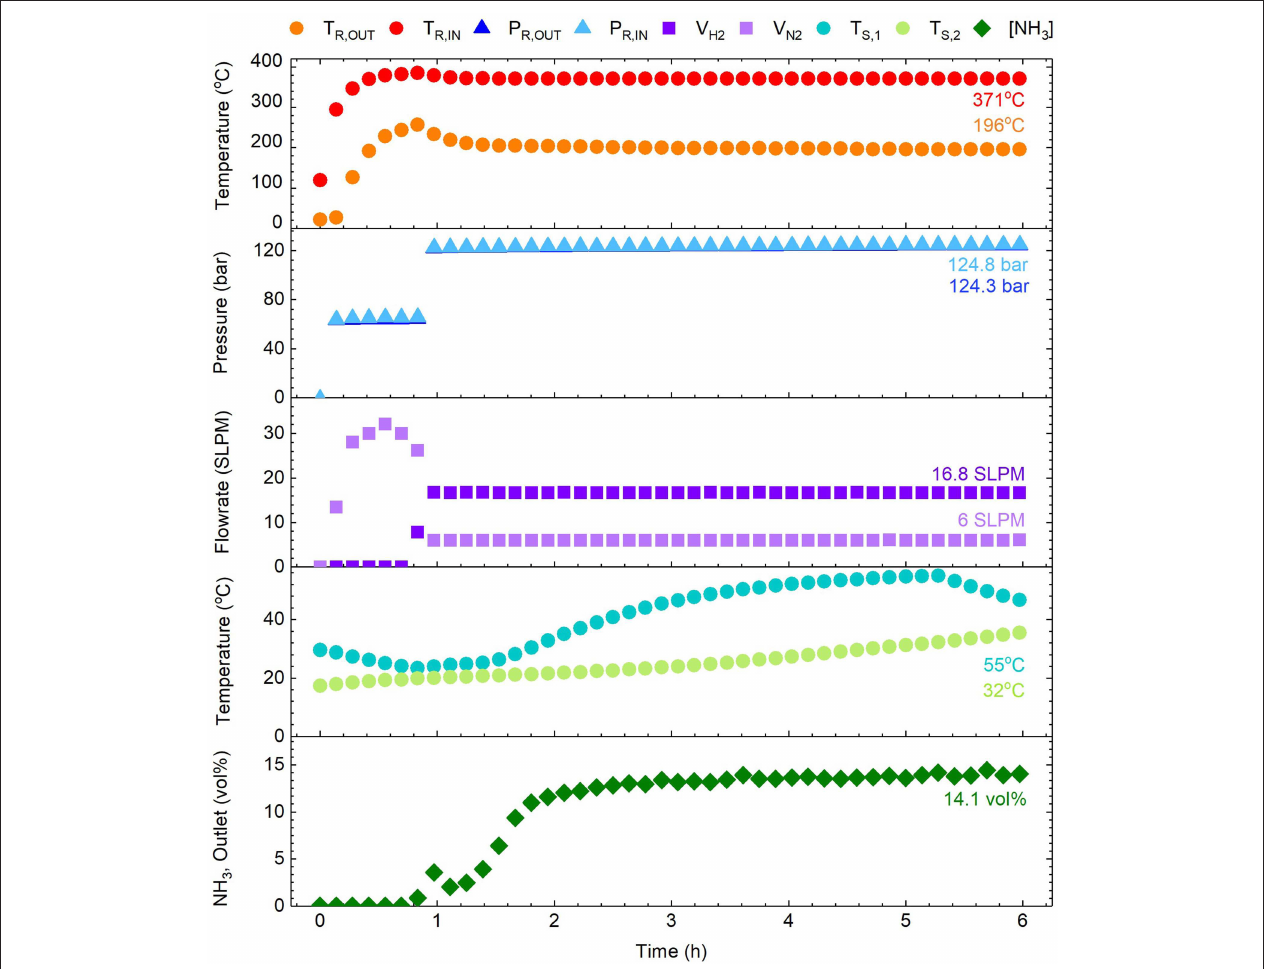
FIGURE 3 | Example ammonia synthesis experiment showing parameters such as the reactor temperatures (T R,IN and T R,OUT ), pressures (P R,IN and P R,OUT ), feed gas flowrates (V H2 and V N2 ), scrubber temperatures (T S,1 and T S,2 ), and the ammonia concentration in the outlet gas ([NH 3 ]). Note that the P R,IN and P R,OUT data points are almost coincidental on the plot ( 1 P ≈ 0.5 bar).